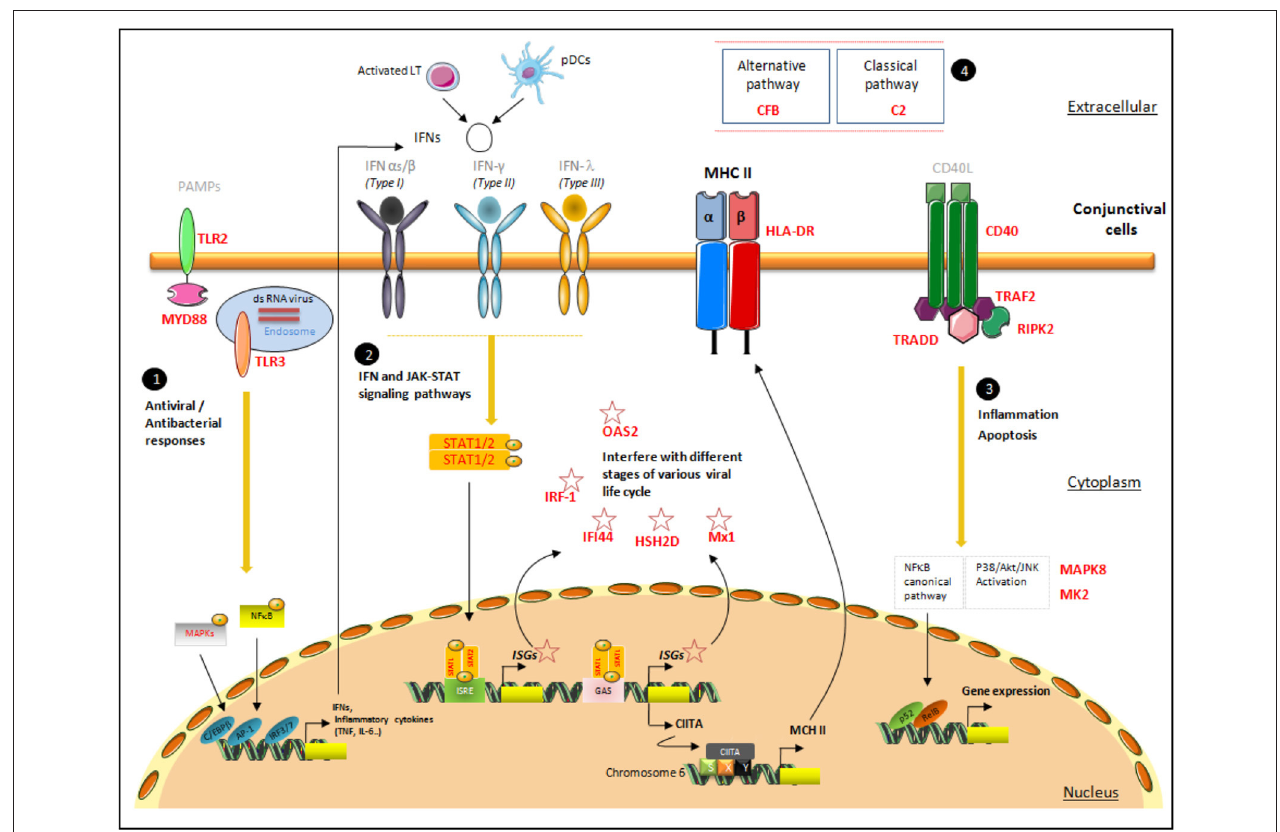
FIGURE 3 | Proposal for a pattern of signaling pathways associated with increased HLA-DR expression in conjunctival cells. This figure presents the localization of the targets identified with their possible interactions in the conjunctiva’s spatial microenvironment. The four major signaling responses, in black circles, are mediated by (1) TLR responses, (2) IFN responses, (3) TNF responses, and (4) members of complement pathways. The target genes selected via their high correlation with HLA-DR are mentioned in bold red. The first line of pathogen recognition could be mediated by TLR responses via MAPK and NF- κ B to induce inflammatory cytokine responses as INFs. IFNs bind to their receptors and initiate a signaling cascade, involving the JAK-STAT family of transcription factors, which leads to the transcriptional induction of the ISGs (IRF-1, IFI-44, HSH2D, Mx1, and OAS2), class II transactivator (CII-TA), and HLA-DR complex, which will migrate to the membrane. CD40, TRAF2, TRADD, and RIPK2, involved in TNF pathways, promote NF- κ B and the MAPK family: MK2 and MAPK8, members of the p38 MAPK and JNK cascades, respectively. Pathogen-associated molecular patterns (PAMPs); CCAAT/enhancer binding protein beta(C/EBP β ); AP-1 transcription factor subunit(AP − 1); IFN regulatory factor IRF-3 and IRF-7(IRF3/7); IFN-stimulated response element (ISRE); IFN γ -activated site (GAS); phosphate(P); class II transactivator (CIITA); MHC class II-specific regulatory module (XYS); nuclear factor kappa B subunit 2(p52); NF- κ B subunit transcription factor RelB